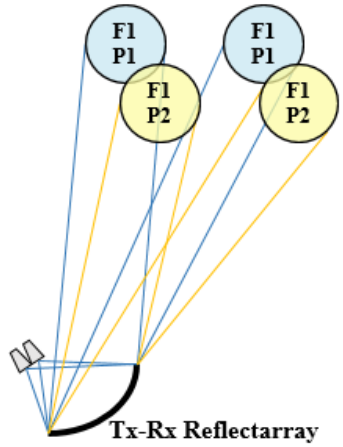
Figure 15. Operating principle of the proposed single-band parabolic reflectarray.